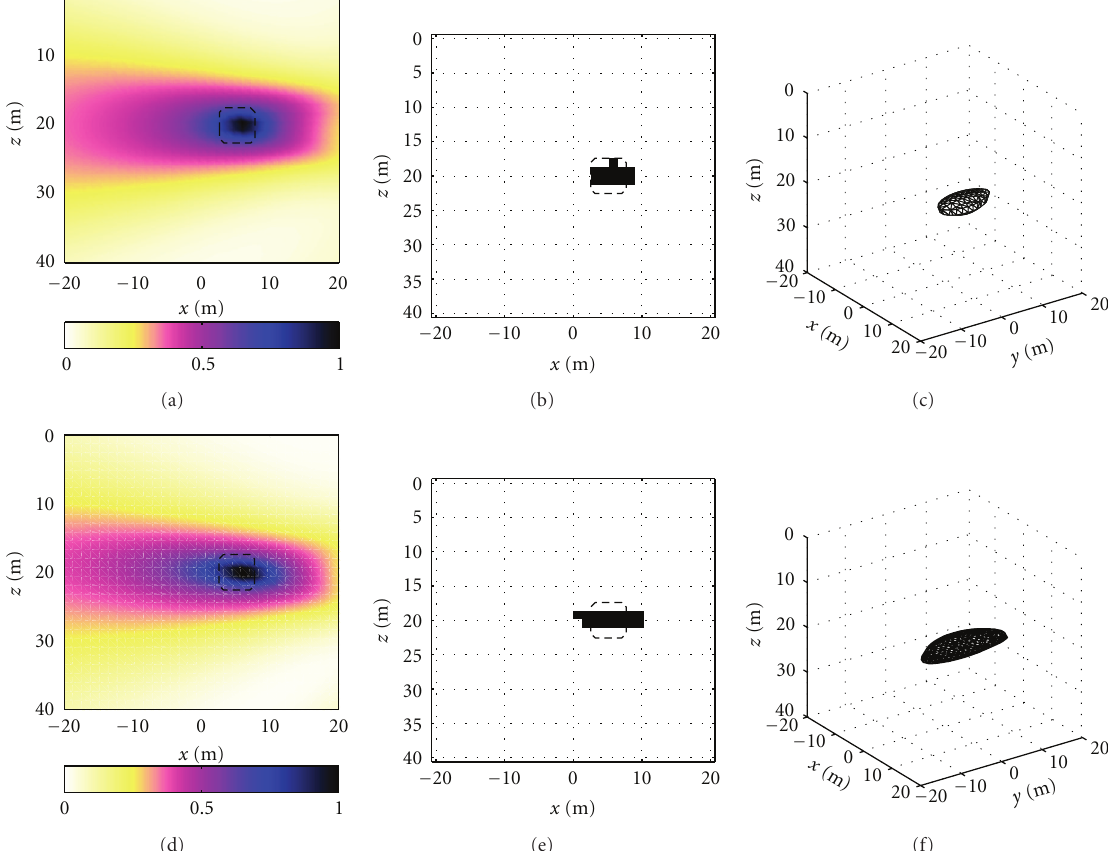
Figure 4: LSM imaging of the tunnel in the reflection measurement setup. Normalized logarithmic plot of the LSM indicator, binarized LSM indicator with threshold 0.75, and binarized three-dimensional LSM indicator in the whole region: (a)–(c) vertical dipoles and (d)–(f) horizontal